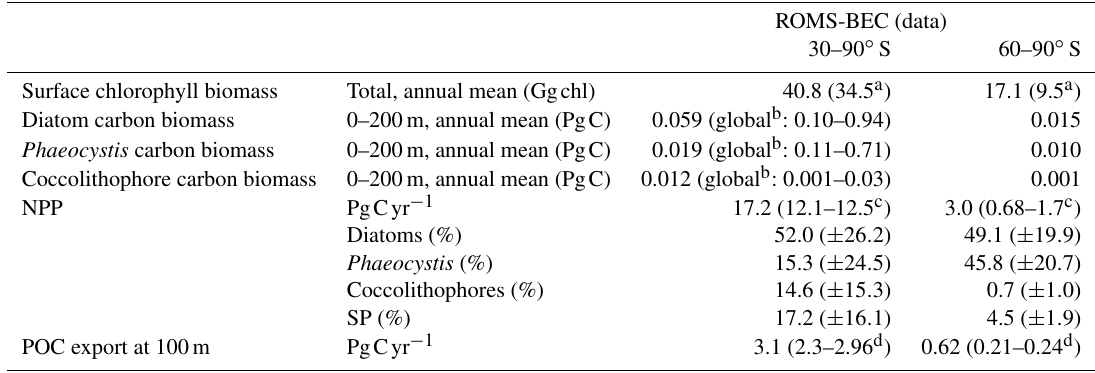
Table 3. Comparison of ROMS-BEC-based phytoplankton biomass, production, and export estimates with available observations (given in parentheses). Data sources are given below the table. The reported uncertainty of the contribution of the PFTs to the simulated integrated NPP corresponds to the area-weighted spatial variability of each PFT’s contribution to annual NPP (1 σ in